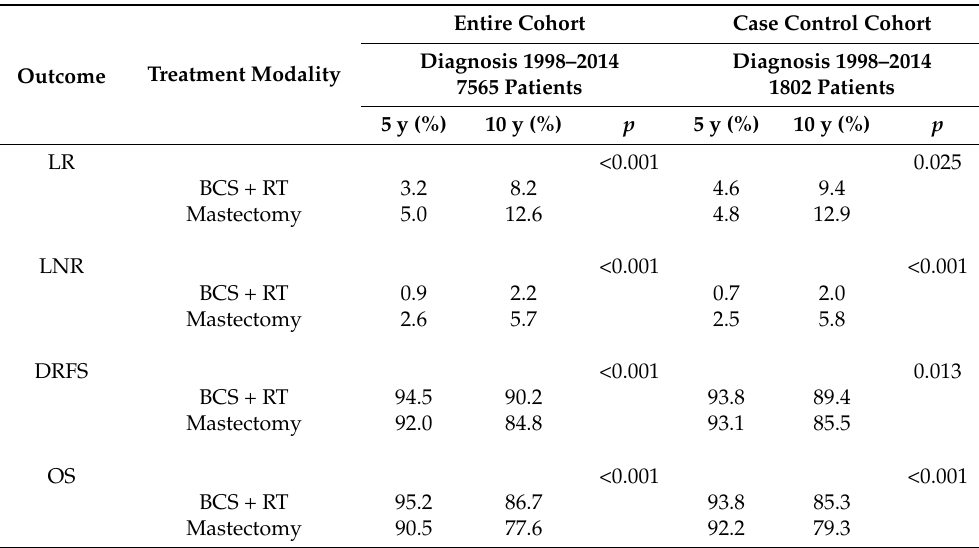
Table 2. Cumulative incidence of local recurrences (LR) and lymph node recurrences (LNR) and Kaplan-Meier estimates of distant recurrence-free survival (DRFS) and overall survival (OS) for patients of the different cohorts. BCS + RT: breast-conserving surgery with postoperative radiotherapy; Mastectomy: mastectomy without radiotherapy; y: years.